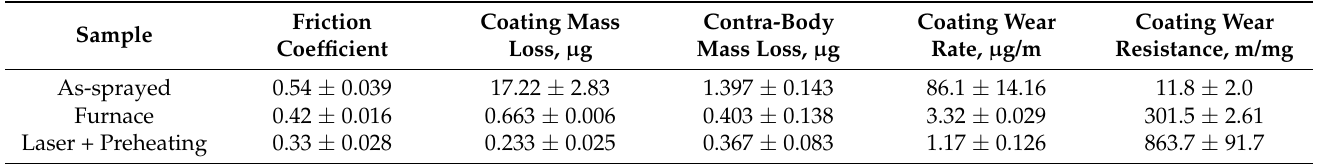
Table 4. Results of the tribological